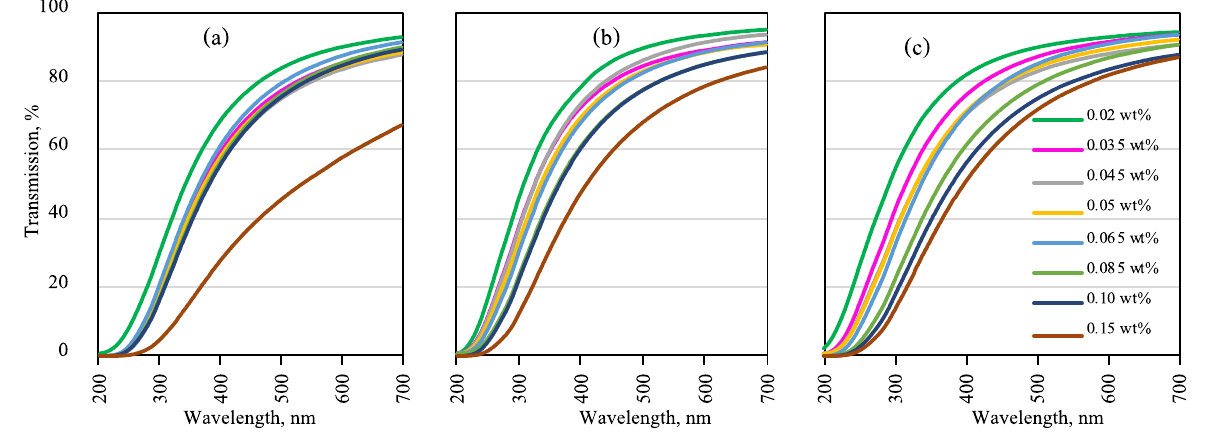
Figure 31: E ff ect of sonication on the dispersion of CNCs in DI water based on UV - Vis spectroscopy after ( a ) 2 min, ( b ) 10 min, ( c ) and 30 min sonication, reprinted with permission from ref. [ 76 ] ; Copyright 2021, Elsevier